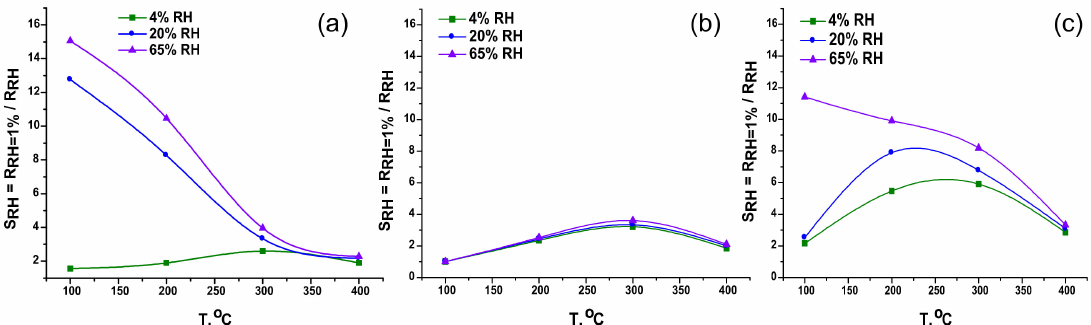
Figure 12. Temperature dependences of the response to water vapor of: ( a ) SnO 2 ; ( b ) SnSi13; ( c ) SnSi19 at RH = 4, 20 and 65% (at 25 ◦ C).